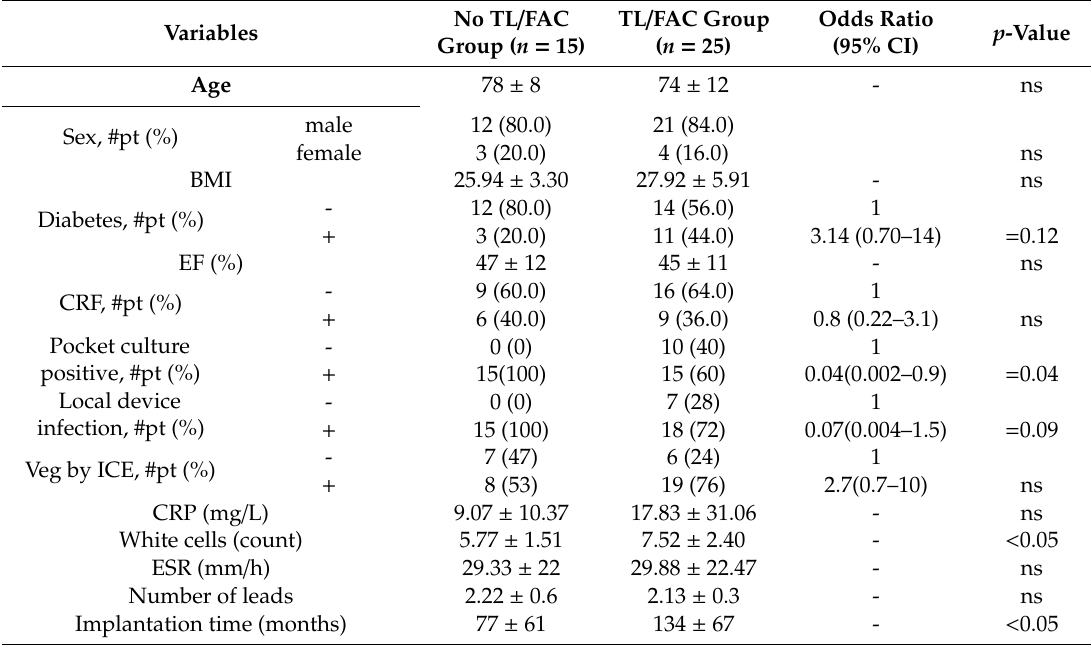
Table 2. Factors modulating ICE signs of lead fibrosis (univariate analysis).